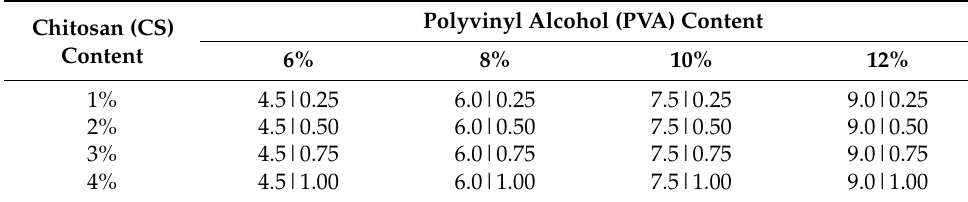
Table 1. Composition of the blended PVA and CS (PVA|CS) formulations. The PVA and CS contents show the concentration of the previous solution. The resulting values show the concentration of polyvinyl alcohol relative to chitosan (PVA|CS) after mixing in the proportion of 75:25. Chitosan